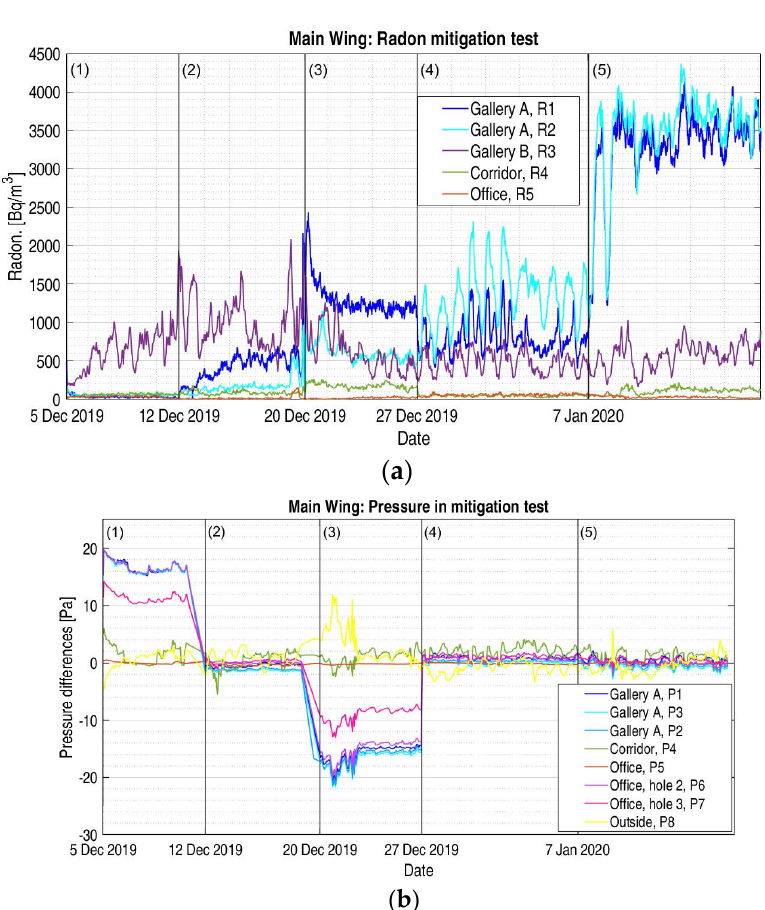
Figure 8. ( a ) Levels of radon in main wing spaces. Natural state (reference state). ( b ) Pressure in main wing spaces. Natural state (reference state). Pressure reference on office floor.